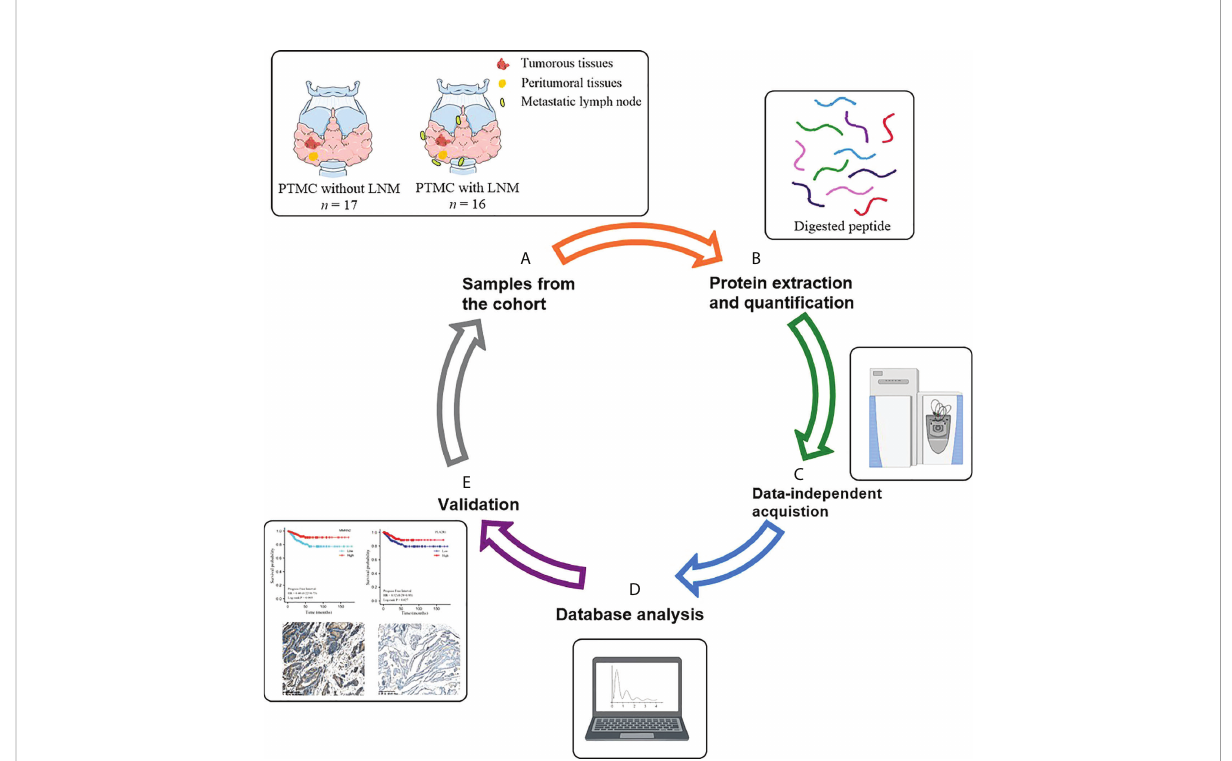
FIGURE 1 Schematic diagram of the experimental work fl ow employed in this study. (A) Collection of neoplastic tissues and peritumoral tissues from PTMC patients; (B) High-throughput sample including tissue grinding and lysis, and protein extraction and quanti fi cation; (C) Direct data-independent acquisition analysis of tissue proteomics and data processing; (D) Bioinformatics and statistical analyses; (E) Validation. PTMC, papillary thyroid microcarcinoma; LNM, lymph node